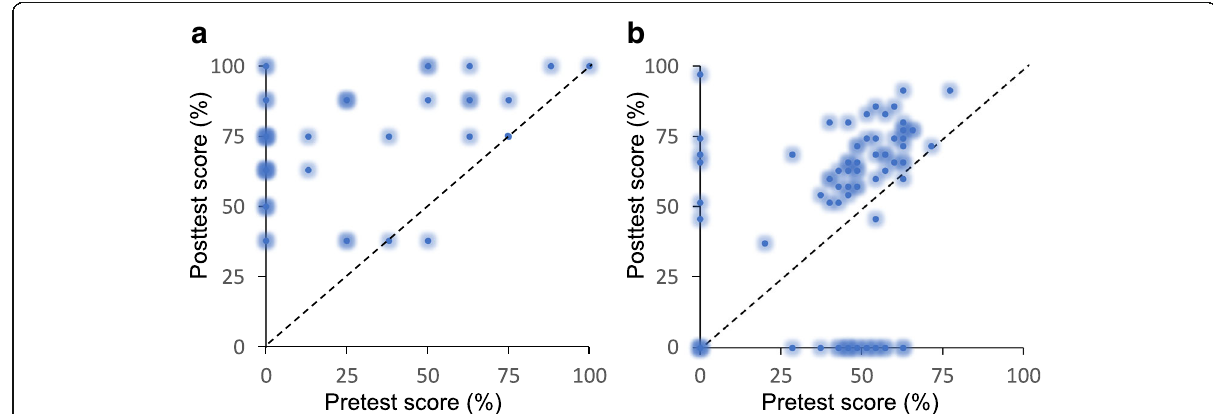
Fig. 6 Pre- and posttest scores in a 2016 ( N pre = 59, N post = 49) and b 2017 ( N pre = 67, N post = 56). The intensity of each point is proportional to the number of students with the given scores. Note that the tests in a and b were